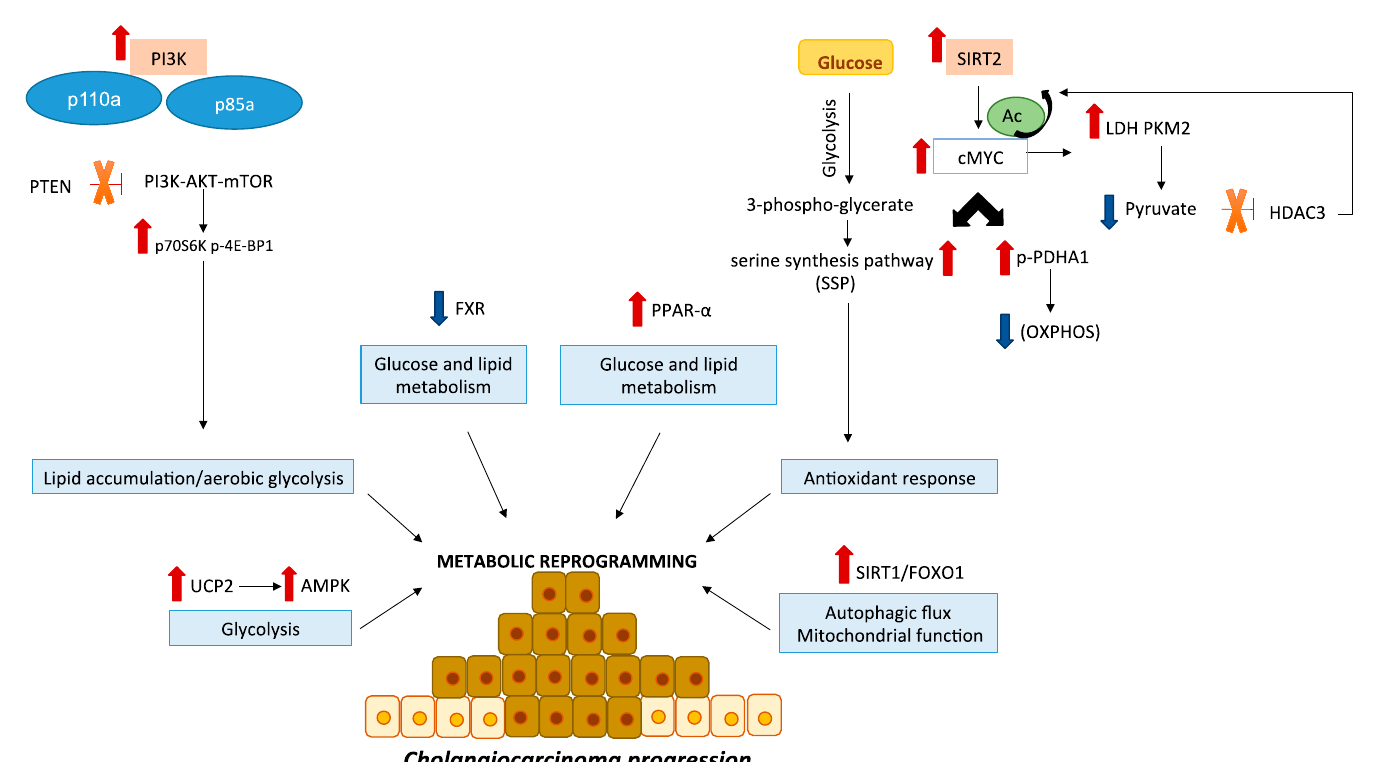
Figure 1. Crucial signaling pathways in CCA metabolism. The PI3K / AKT / mTOR pathway is an essential modulator of cell metabolism, growth and survival in CCA. Activating mutations of gene coding for the p110a and p85a subunits of PI3K and loss of the phosphatase and tensin homolog (PTEN) have been reported in CCA. Moreover, it has been shown the overexpression of downstream mTOR e ff ectors, such as p70S6K and p-4E-BP1. SIRT2 / cMYC pathway is overexpressed in CCA cell lines and mediates the activation of the PDHA1 by inhibition the OXPHOS as well as the activation of SSP that acts against ROS production. During CCA progression increase lactate levels while pyruvate levels decrease. Moreover, cMyc induces an increase of LDH and PKM2 expression, which afterwards reduces pyruvate levels. Being the pyruvate an HDAC3 inhibitor, a reduction of its levels removes HDAC3 inhibition and promotes cMyc overexpression. Sirt1 / FOXO1 pathway is involved in autophagy and mitochondrial functions. UCP2 promotes CCA development through AMPK pathway. FXR expression is downregulated in human tissues and CCA cell lines inducing tumor progression by modulating cellular metabolism. PPAR- α is overexpressed in CCA patients and modulates several genes involved in glucose and lipid metabolism as well as immune responses. All these alterations induce the activation of pathways that promote CCA progression through a reprogramming of cellular